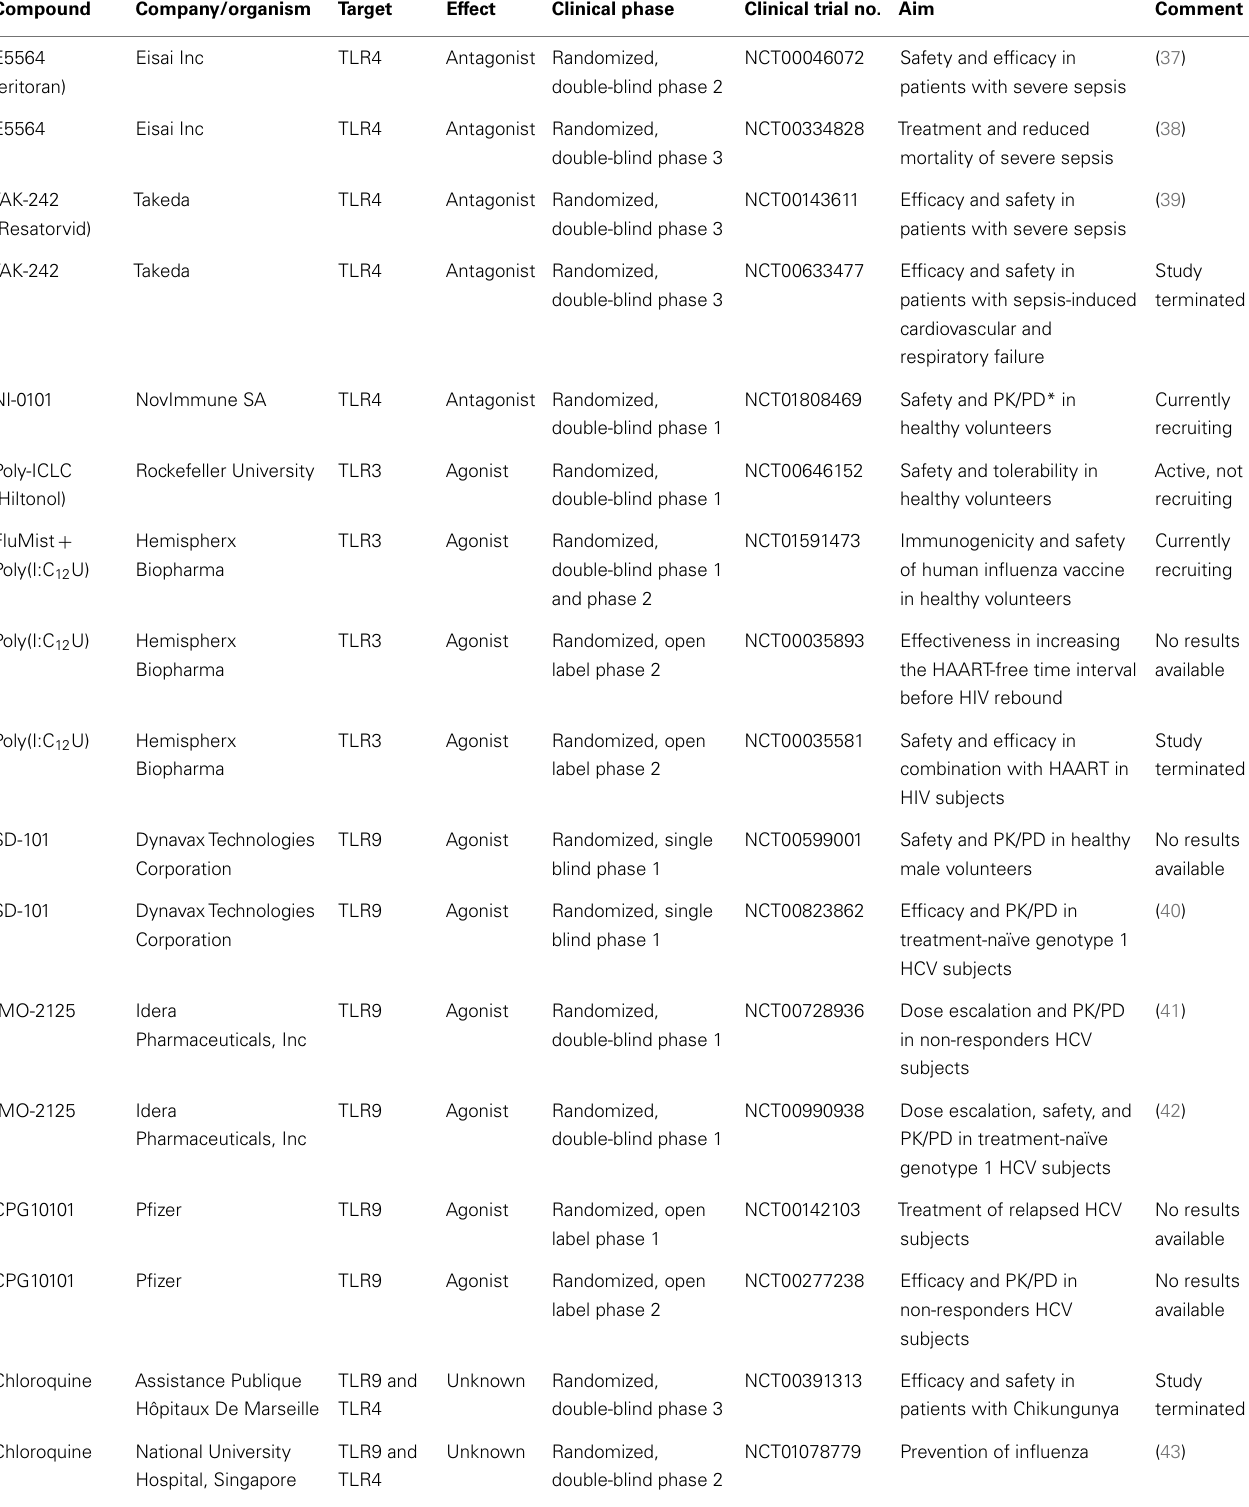
Table 2 | Selection of clinical trials testing drugs targetingTLRs for bacterial and viral infections